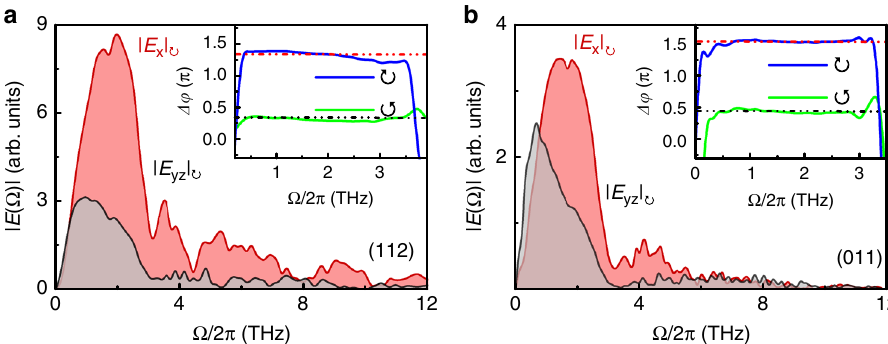
Fig. 3 Fourier transformed spectra for the THz near- fi eld E( t ). a and b are from (112) and (011) faces for circularly polarized pump light, respectively. The insets show the phase difference ( Δ φ ) between E x ( Ω ) and E yz ( Ω ) for each circularly polarized pump light. The dashed lines represent the average value of Δ φ .